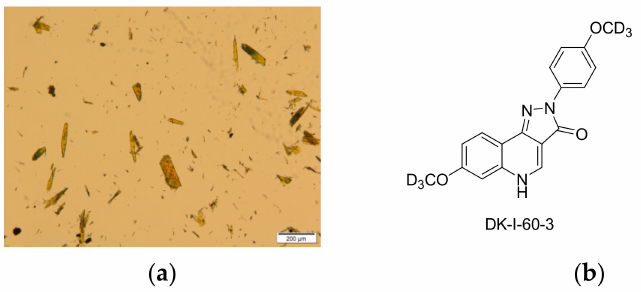
Figure 1. ( a ) Micrograph of coarse DK-I-60-3 powder; ( b ) chemical structure of